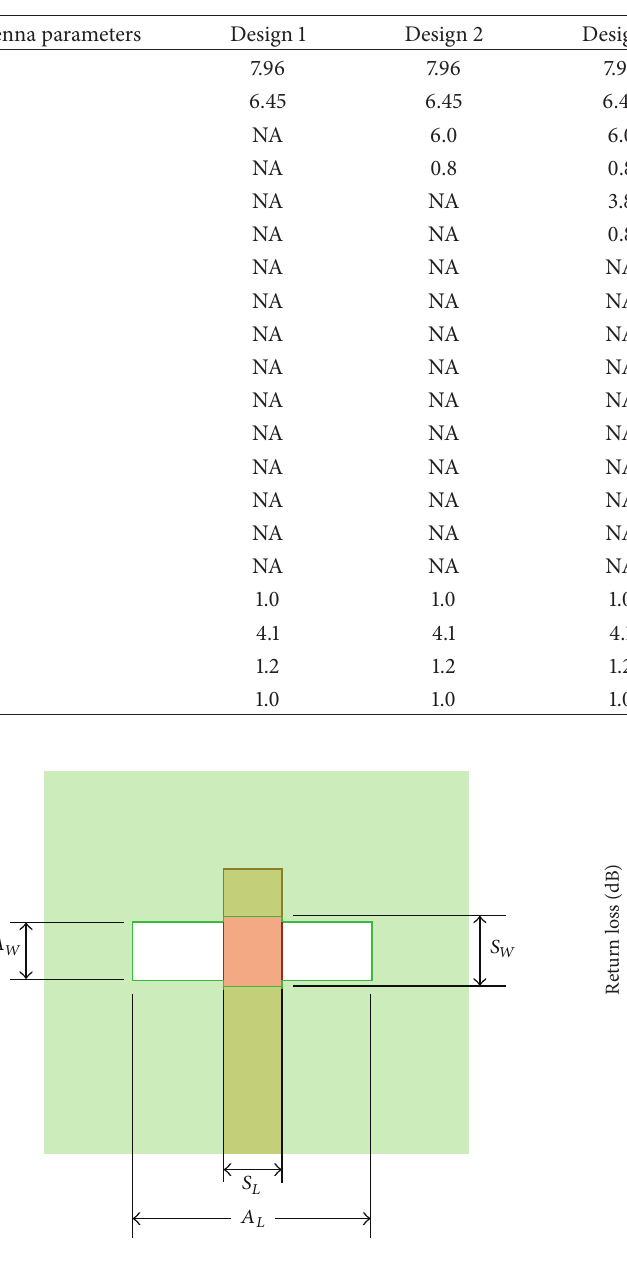
Table 1: Geometrical parameters of analyzed antenna (all dimensions in mm).